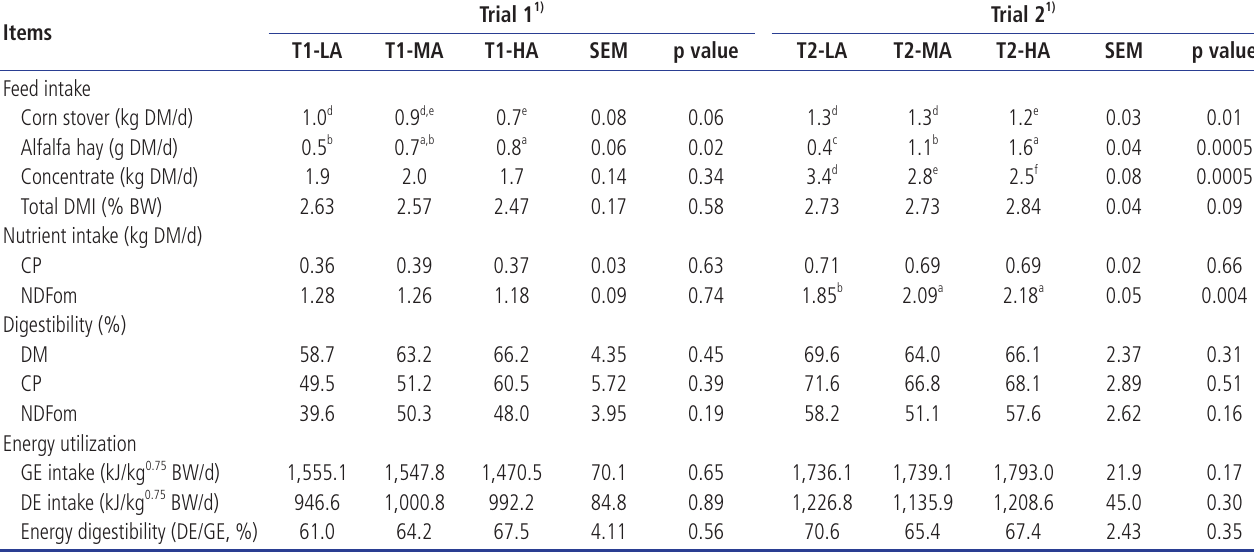
Table 3. Feed and nutrient intake, digestibility, and energy utilization in Simmental crossbred beef calves with different levels of alfalfa hay in their diets Items